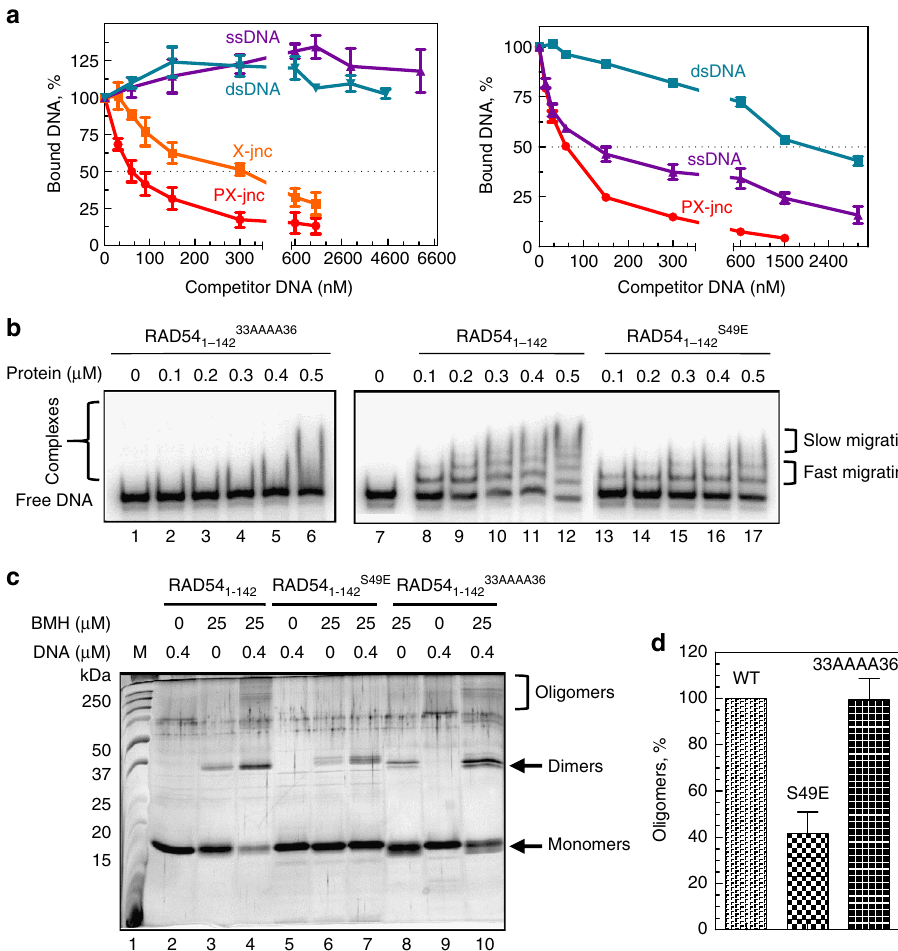
Fig. 4 The DNA-binding properties of RAD54 1 – 142 . a RAD54 1 – 142 (300 nM) or RAD54 156 – 747 (100 nM) was incubated with 32 P-labeled non-mobile PX junction (no. 174/175/176/181; 30 nM) in the presence of the indicated concentrations of unlabeled DNA competitors. The complexes were analyzed by EMSA. b The effect of the S49E and 33AAAA36 mutations on RAD54 1 – 142 binding to PX junction (no. 174/175/176/181; 30 nM) was analyzed by EMSA in a 6% polyacrylamide gel. c The S49E, but not the 33AAAA36, mutation inhibits DNA-dependent oligomerization of RAD54 1 – 142. The proteins (1.2 µ M) were incubated with or without the fl ap DNA (no. 244/249/250; 0.4 µ M) in the presence or absence of BMH (25 µ M) and analyzed in a 15% SDS-PAGE. Arrows indicate migration of the monomeric, dimeric, and oligomeric protein products. The molecular weight standards (Precision Plus; Bio-Rad) are shown. d The relative fractions of the oligomers in c were quanti fi ed and presented as a graph. Each experiment was repeated three times. Error bars represent the